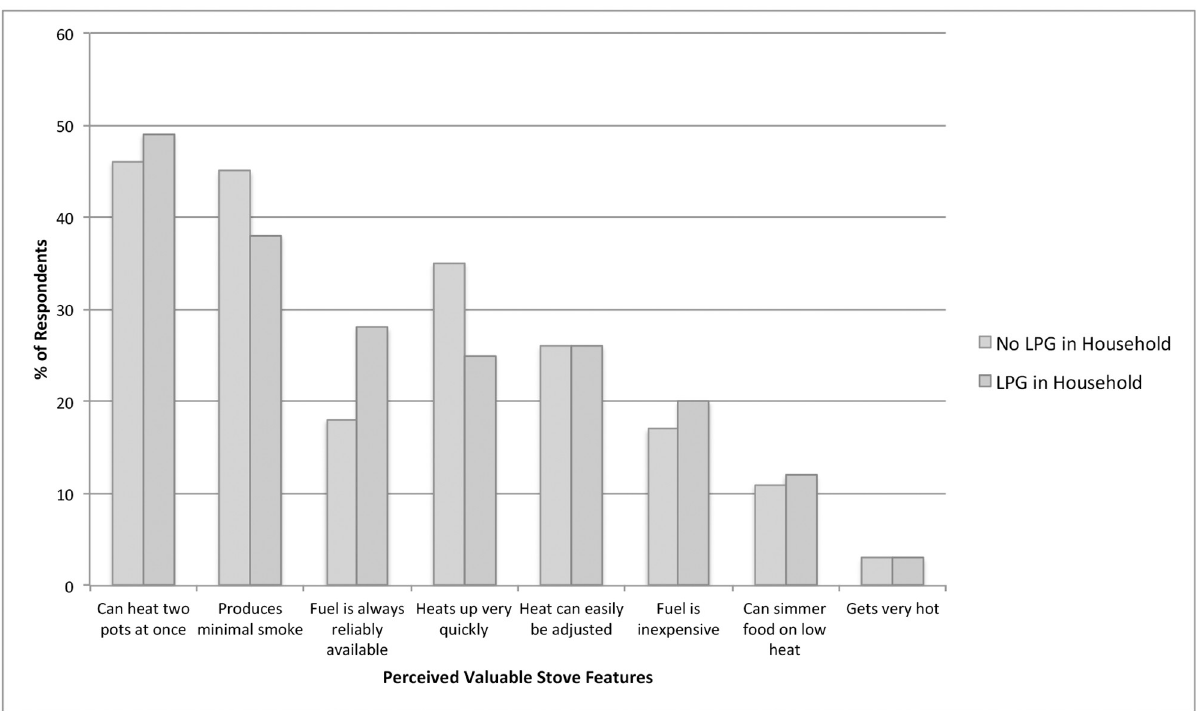
Fig 3. General stove features considered most valuable, stratified by households with and without an LPG